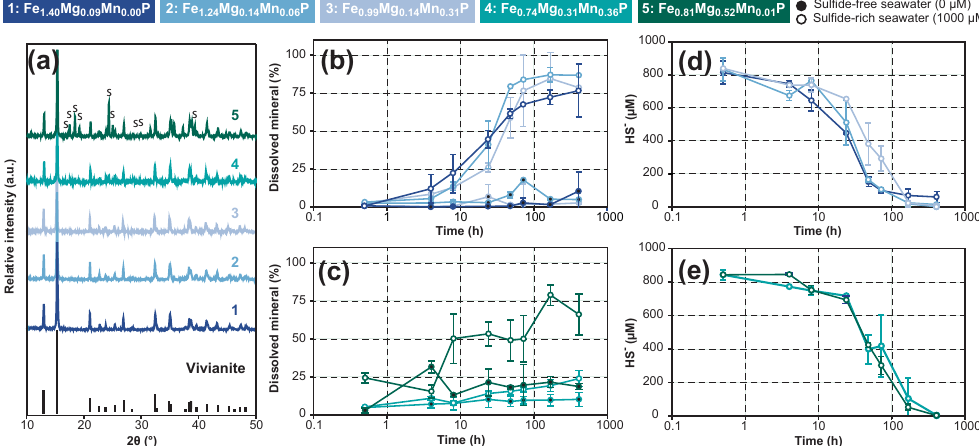
Figure 9. Results from the vivianite sulfidization experiment including the XRD spectra of the precipitates and vivianite (a) , the percentage of dissolved phosphorus (P) mineral (b, c) and the sulfide (HS − ) concentrations in the sample solutions (d, e) . Error bars reveal standard deviations ( n = 2) and sampling time is shown on a logarithmic scale. The XRD spectra of precipitates 4 and 5 also contained diffraction peaks that are indicative for struvite (S). The sulfide concentrations in the samples with 0µM initially were all low ( < 25µM) and therefore not shown in the